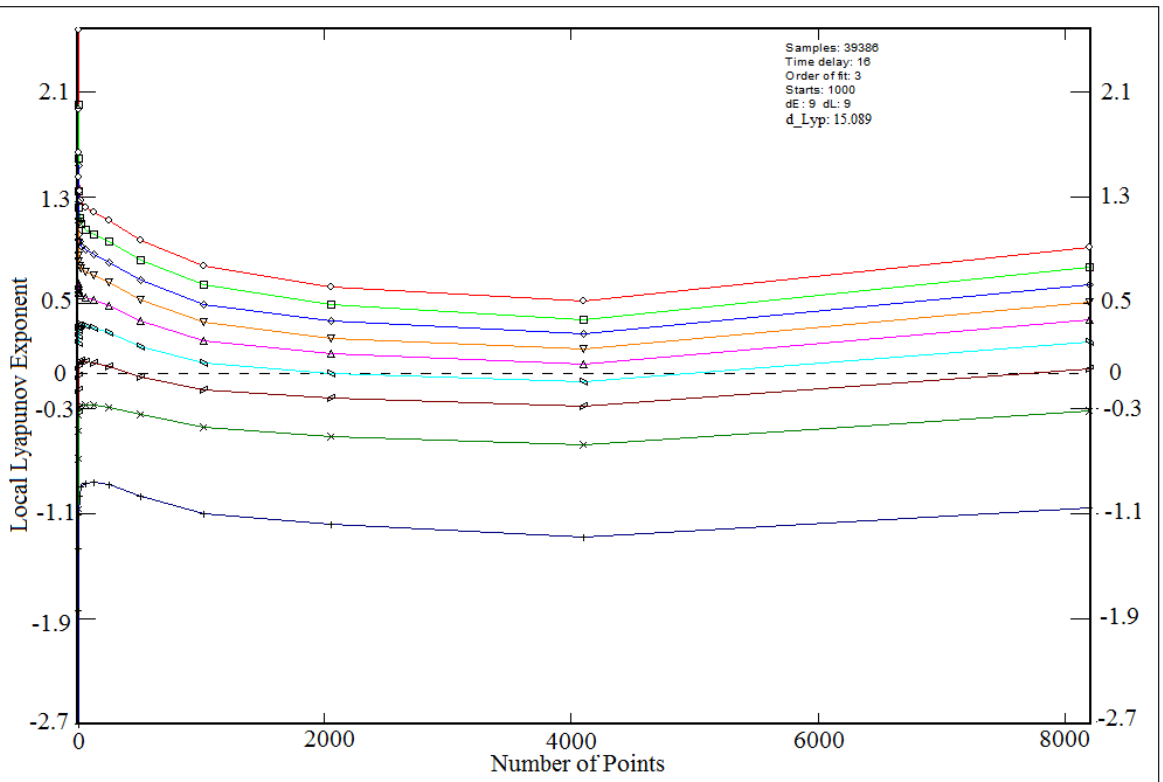
Figure 22. Local Lyapunov exponent when the follower offsets to the right (O = 30 mm) at cam speed (N = 600 rpm), coefficient of restitution (0.4) and follower guide’s clearance (19 mm).